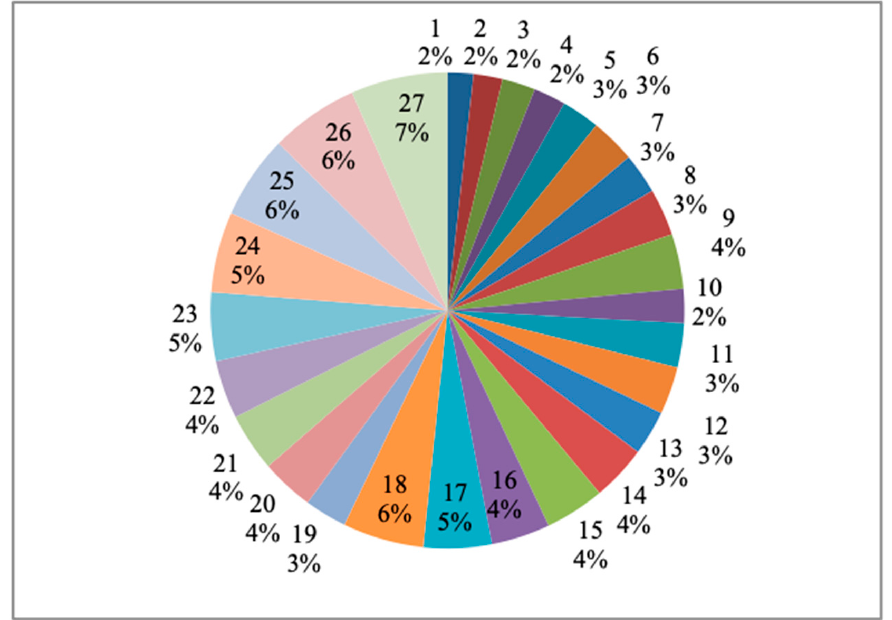
Figure 25. Process parameters influence on the material removal rate (mm 3 /min) for each specimen.